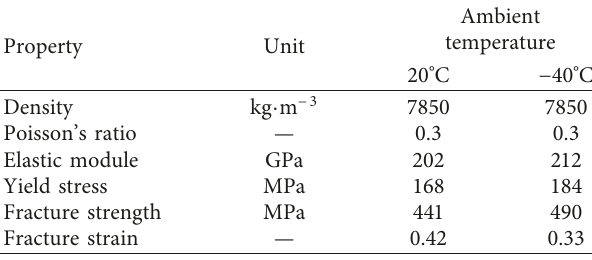
Table 1: Tensile test results at different temperatures.